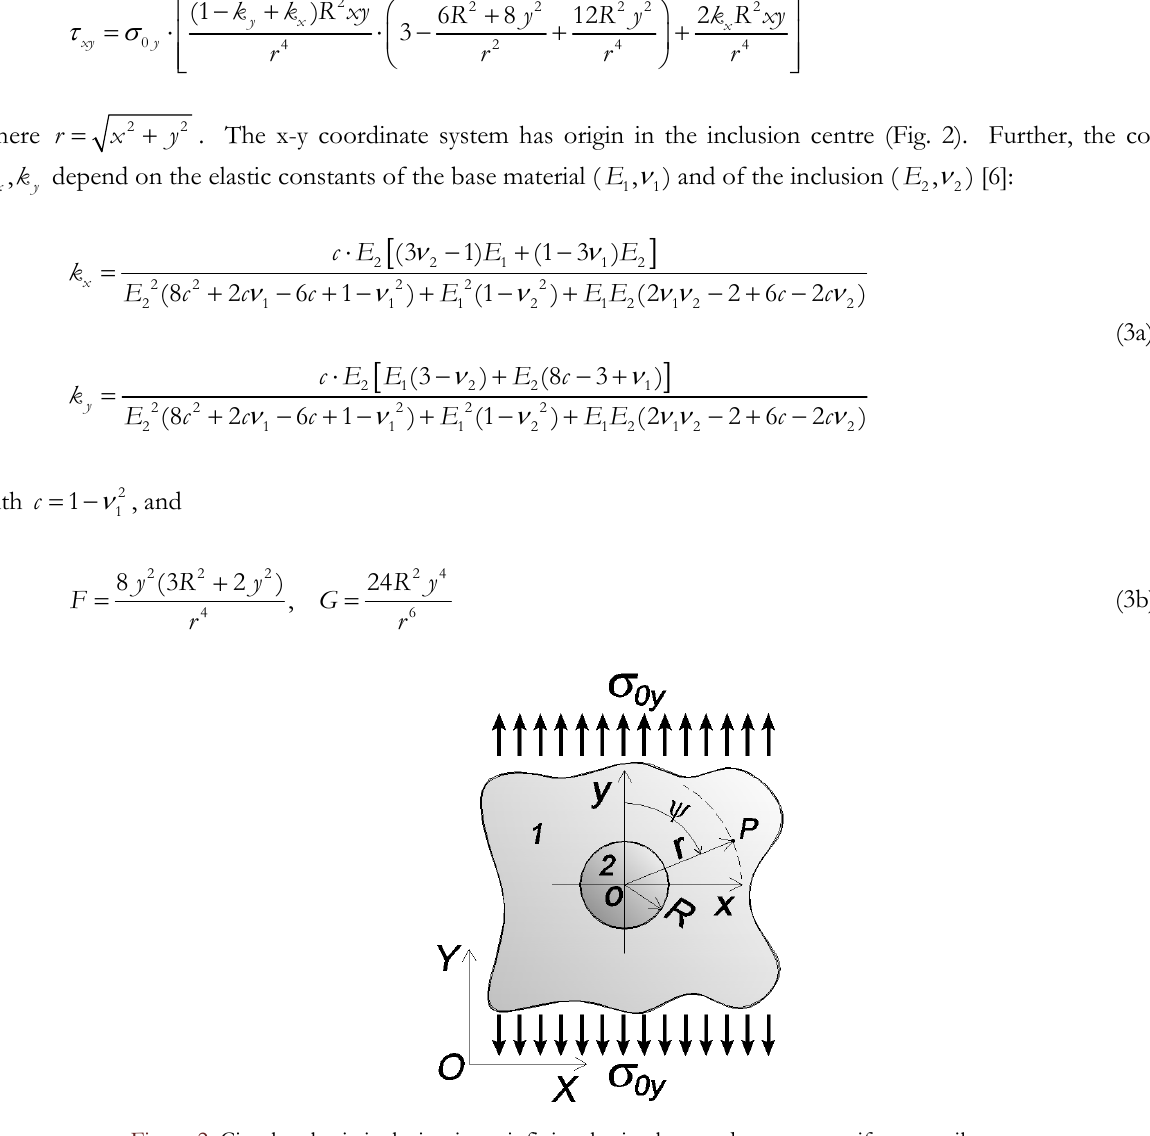
Figure 2: Circular elastic inclusion in an infinite elastic plane under remote uniform tensile stress